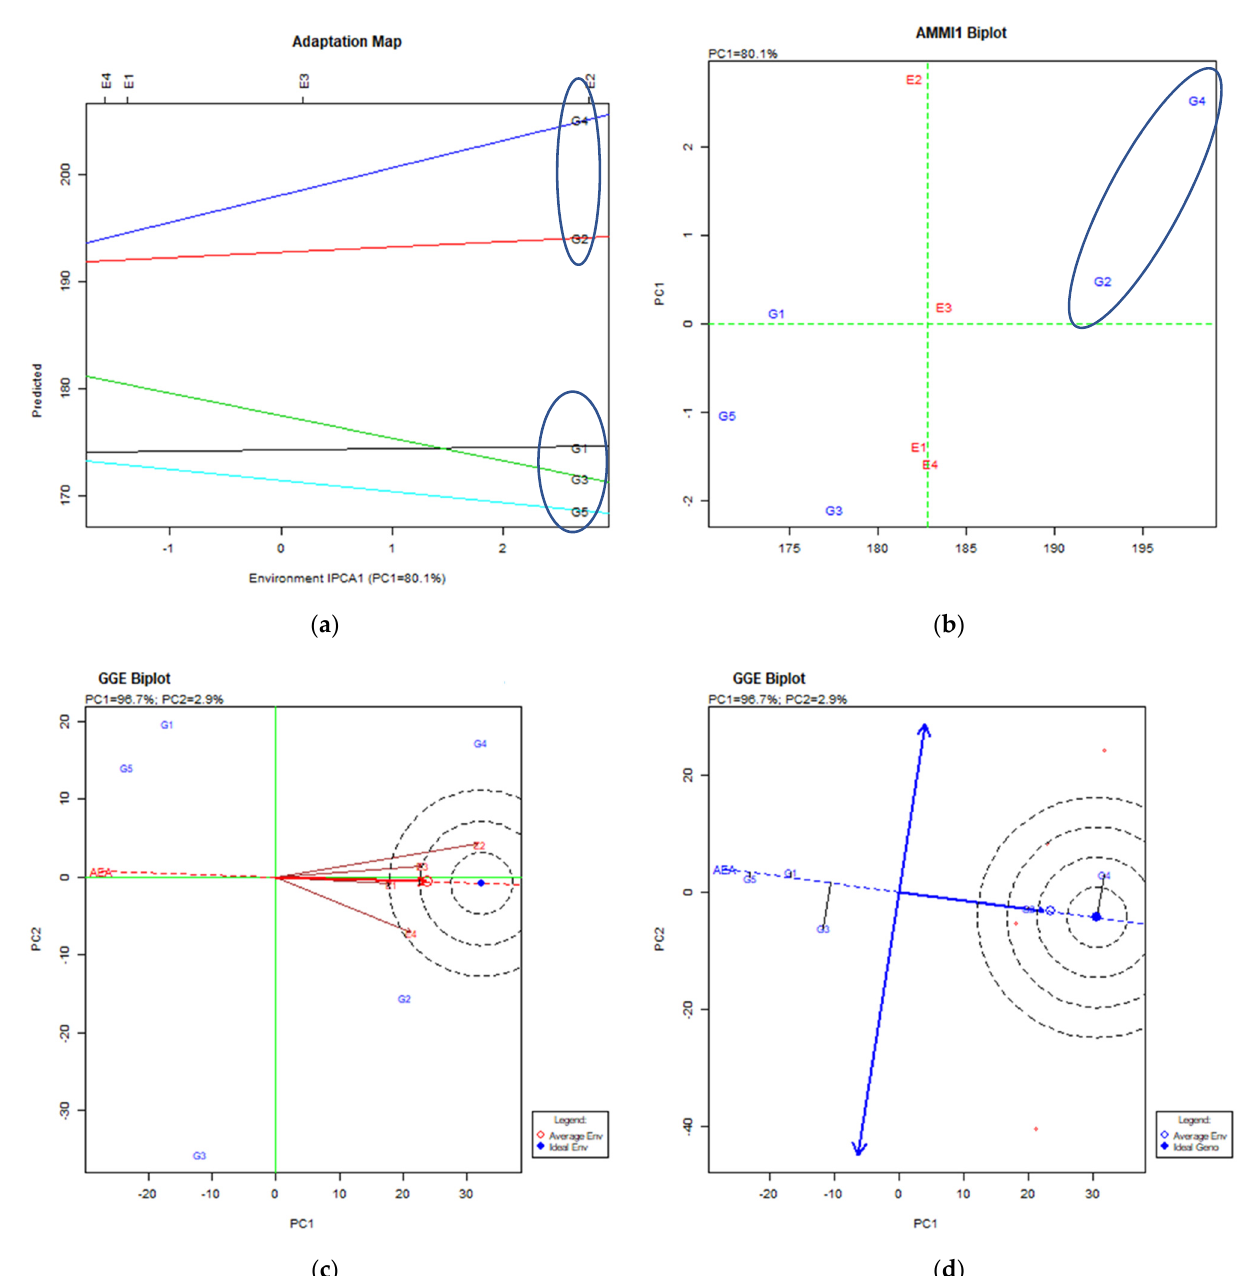
Figure 5. Stability analysis for thousand seed weight (g) based on: ( a ) the adaptation map where the X-axis (PC1) visualizes the stability of cultivars over environments and the Y-axis—the performance of cultivars for the trait; ( b ) the AMMI1 biplot where the Y-axis is the one visualizing the trait performance and the X-axis (PC1) visualizes the stability of cultivars over environments; ( c ) the GGE biplot for environments depicting the stability of the environments over years via the placement as near as possible to the ideal and average environment; ( d ) the GGE biplot for cultivars depicting the stability of the cultivars over environments where the productive cultivars are those to the right on the AEA vector and the stable ones are those which are as close to the AEA axis as possible.